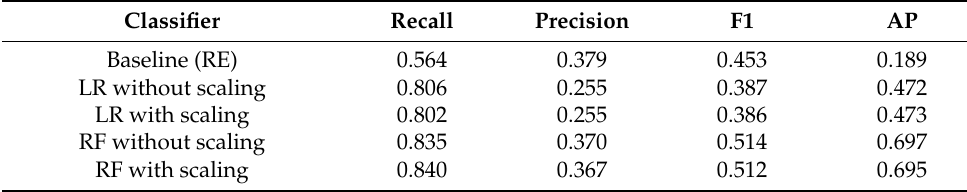
Table 3. Classifier performance with and without scaling.